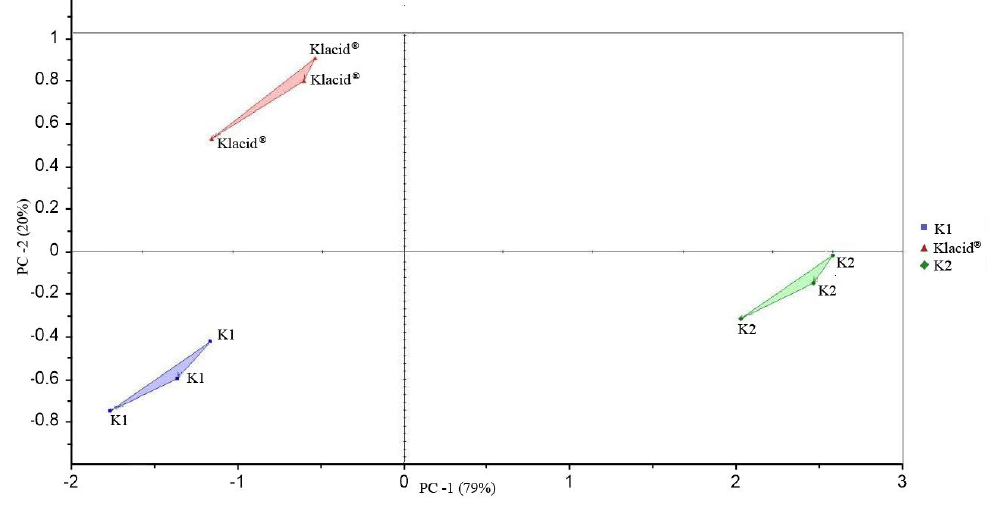
Figure 2. In vitro taste evaluation of clarithromycin suspensions using electrical tongue and principal component analysis (PCA).